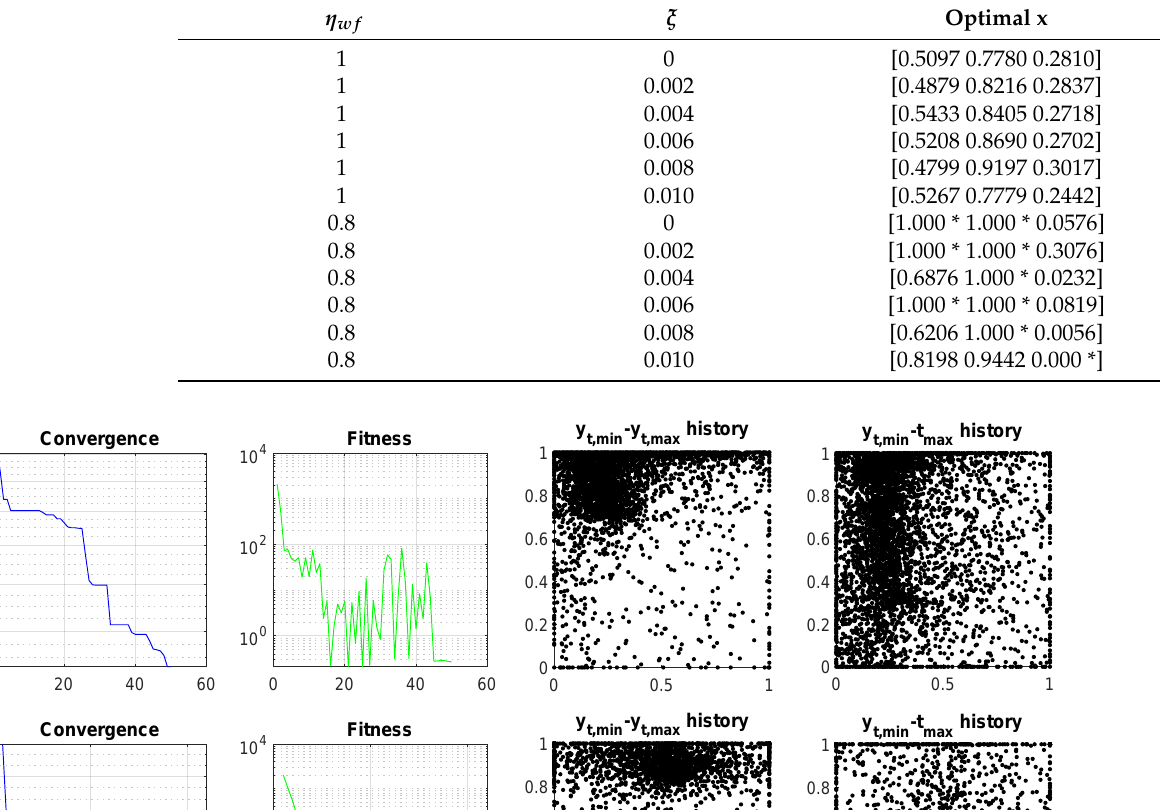
Table 5. PSO summary for two mandates (8 years). * Value falling in a limit of the optimization ranges (13).